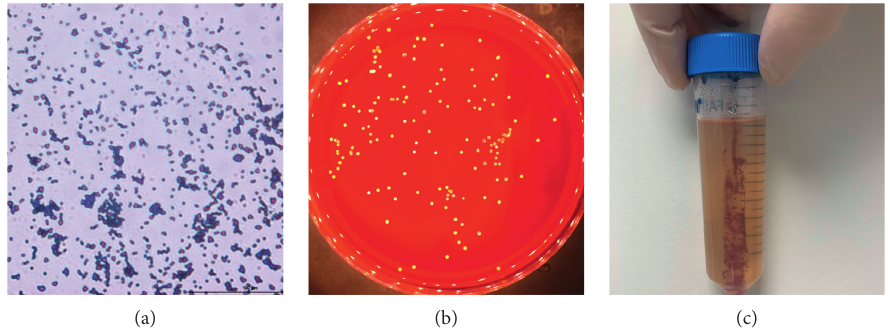
Figure 3: Phenotypic characteristics of Brachybacterium epidermidis strain Marseille-Q2903 T . (a) Gram staining; (b) visualization of the colonies; and (c) motility test.